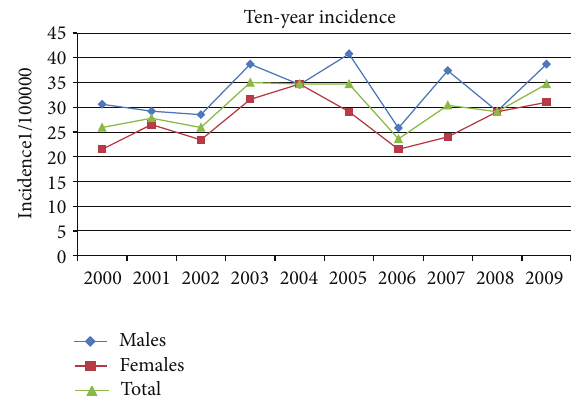
Figure 1: The incidence of acute pancreatitis according to gender during the ten-year period.